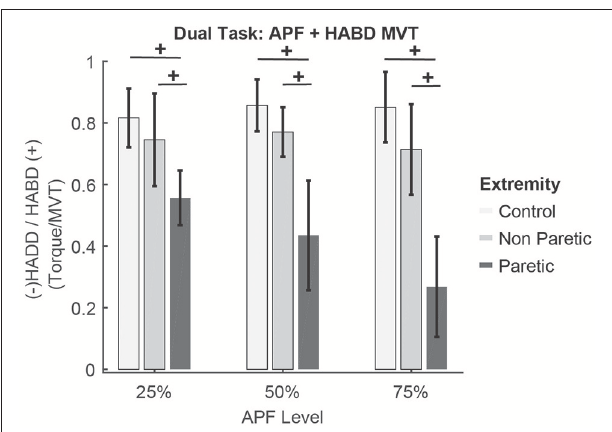
FIGURE 3 | Results for the combined submaximal ankle plantarflexion + hip abduction MVT task. x-axis indicates the percentage of ankle plantarflexion. y-axis indicates the volitional hip abduction or spontaneous hip adduction generated, normalized by hip abduction MVT. Percentages reported in the main text correspond to this normalized value × 100%. + p < 0.05 Sidak post-hoc significant differences across lower extremities in the % hip abduction torque achieved. No differences between levels of plantarflexion were observed. Error bars show standard error of the mean. Colors are those defined in Figure 2